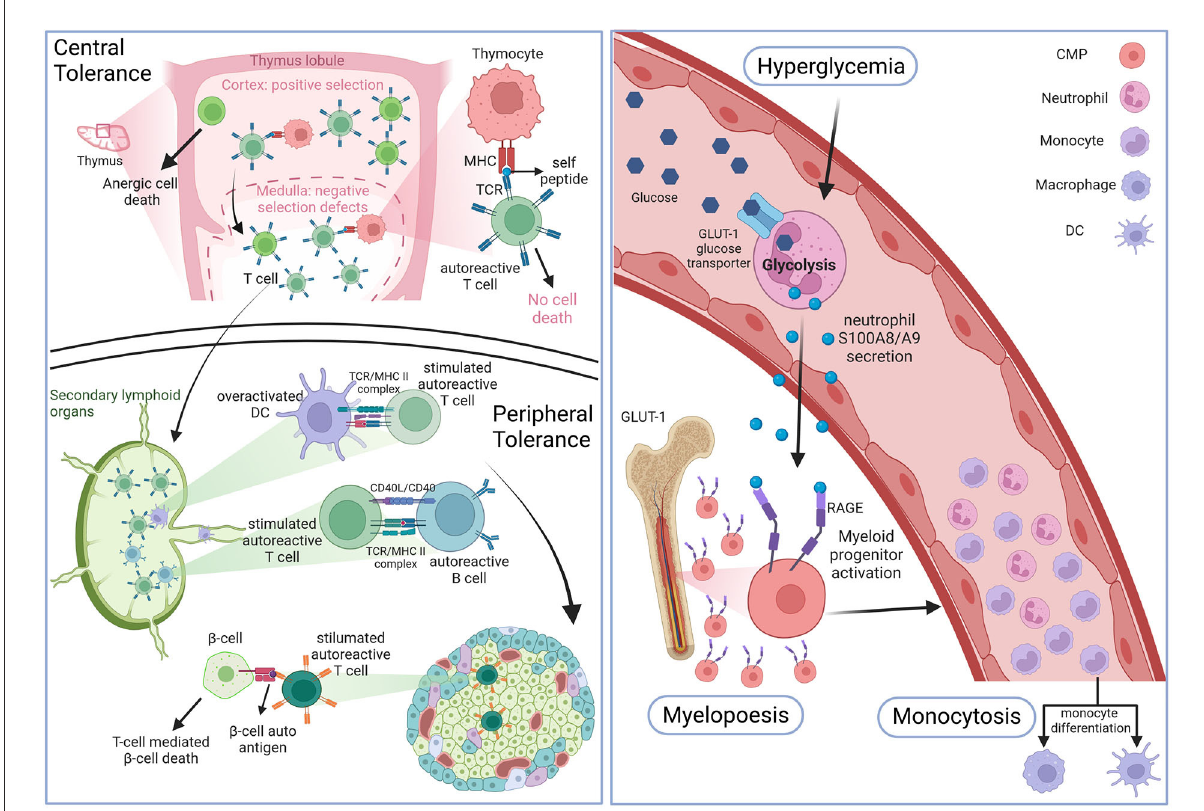
FIGURE1 Hematopoiesis in DM. Top left panel: defects in the negative selection step of the thymic central tolerance process leads to the production of naive autoreactive T cells. Bottom left panel: antigen presenting cells (APCs) prime the naive autoreactive T cells with beta-cell and insulin autoantigens. Once activated the autoreactive T cells destroy pancreatic islet beta-cells. Right panel: high blood glucose levels enter circulating neutrophils through insulin-independent glucose transporter 1, which activates glycolysis and leads to damage associated-molecular patterns DAMPs S100A8/A9 secretion. These DAMPs will bind to receptors of advanced glycation end products (RAGE) at the surface of cellular myeloid progenitors (CMP) to promote myelopoiesis which leads to enhanced monocyte blood levels (monocytosis). Figure created with BioRender.com online